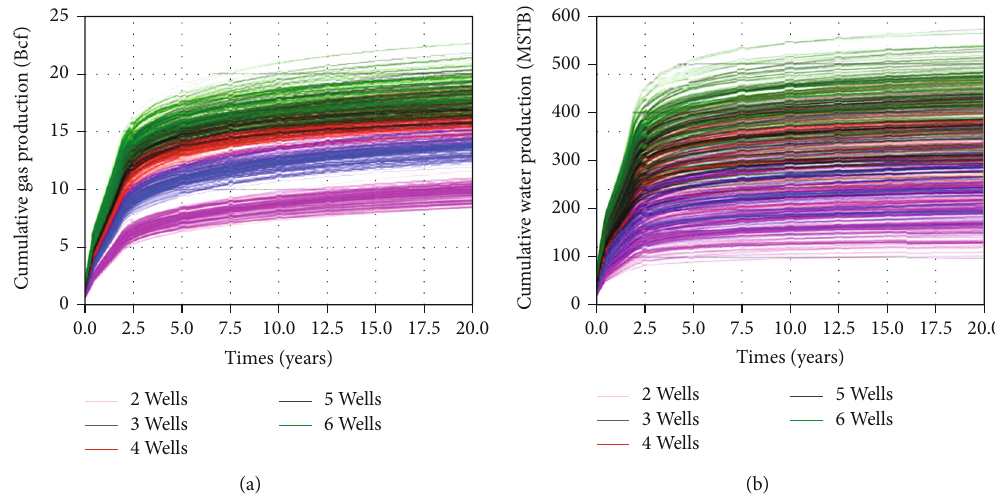
Figure 10: Cumulative gas and water productions for di ff erent well scenarios: (a) cumulative gas production and (b) cumulative water production (Bcf represents billion cubic feet).